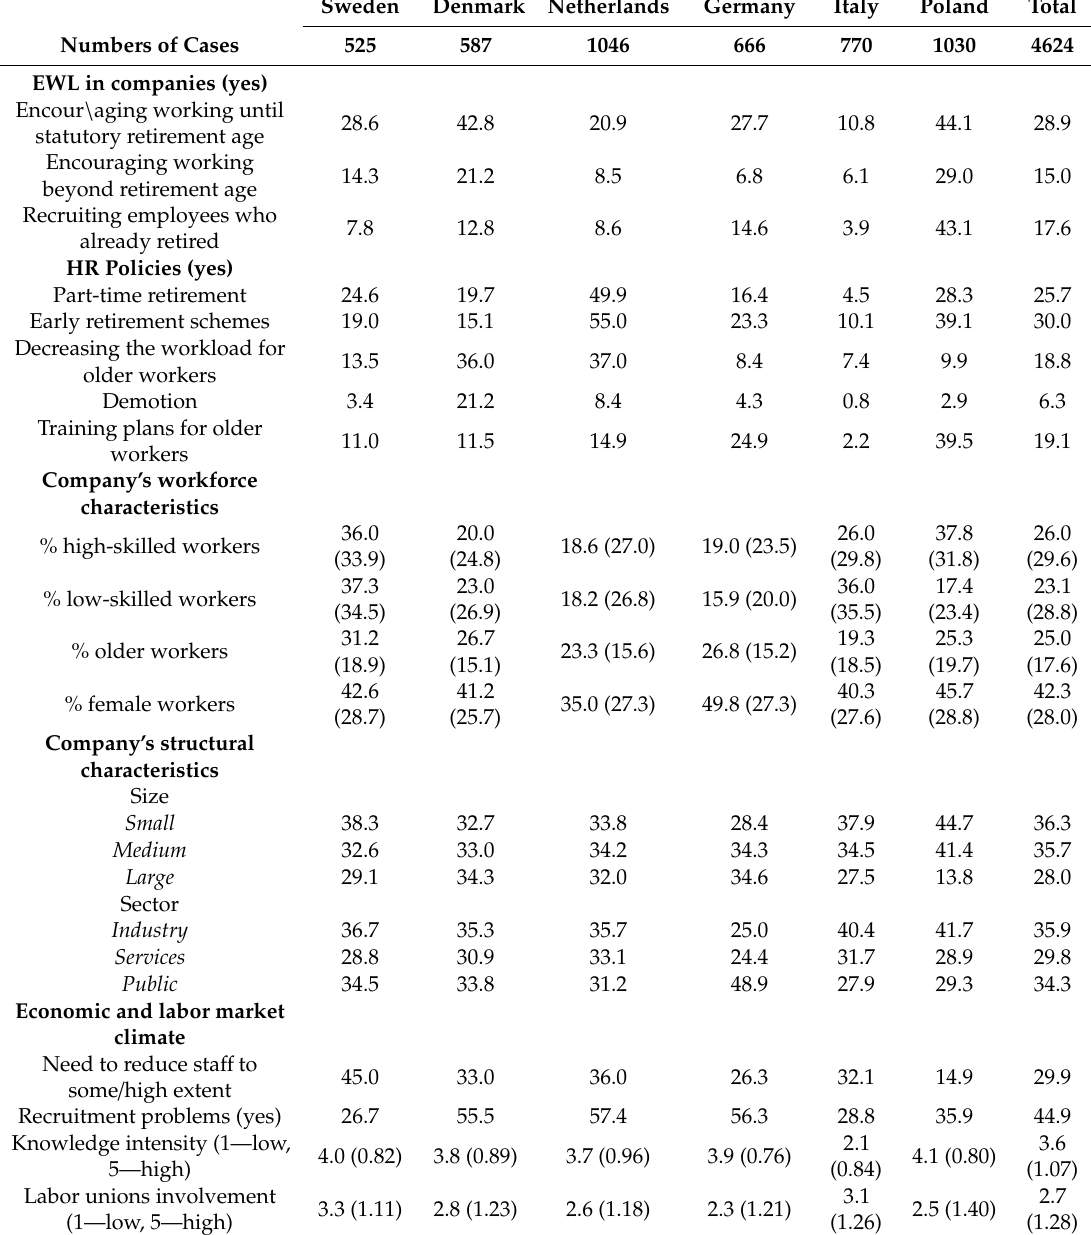
Table 1. Sample characteristics, by country and total sample, % mean